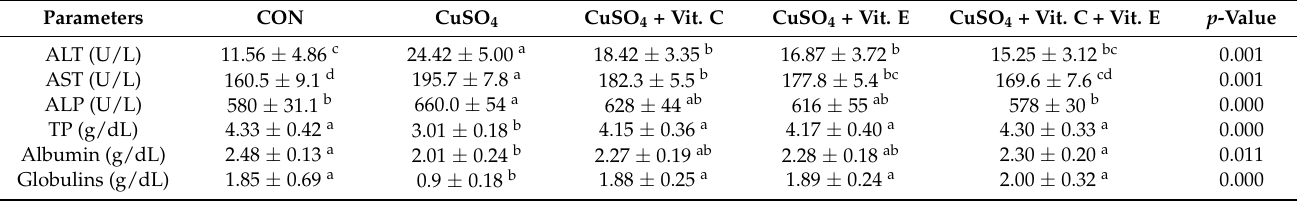
Table 4. Effect of single or combined supplementation of vitamin C and E on broiler chickens’ liver enzyme activities and protein profile at the end of the 6th week (Mean ± SD, n = 5).